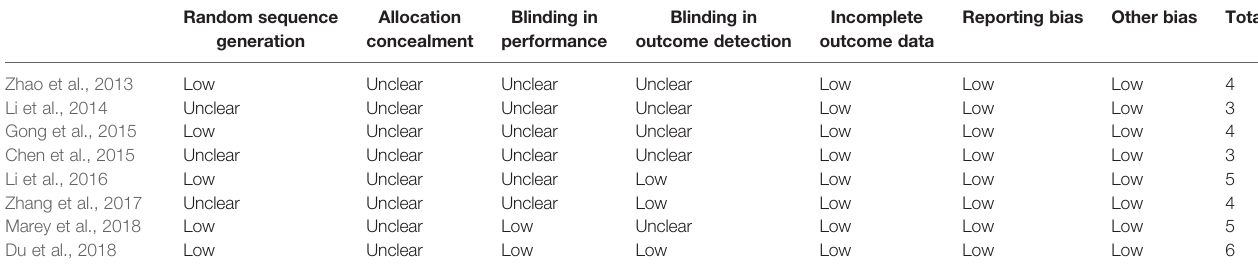
TABLE 2 | Quality evaluation of the included RCTs using the Cochrane ’ s Risk of Bias